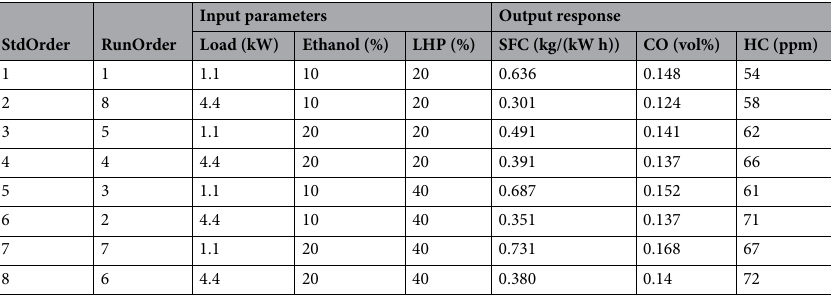
Table 7. Experimental output response of LHP and ethanol